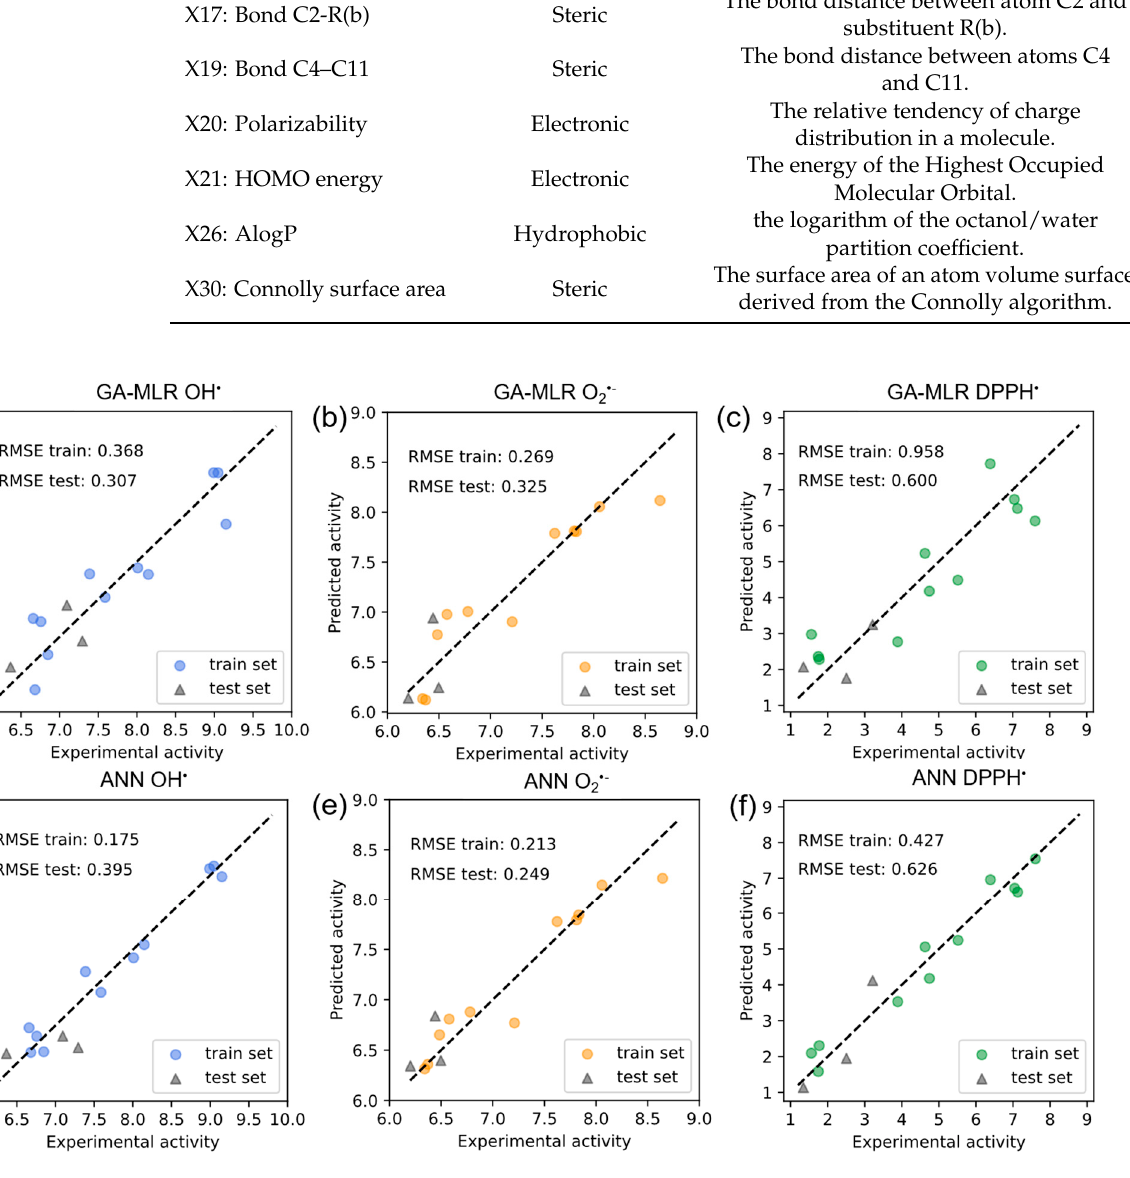
Figure 3. Experimental vs. predicted • OH, O 2• − , and DPPH • scavenging activities (percent scaveng- ing activity/10) for training and test sets. The predicted data were obtained from QSAR GA-MLR ( a – c ) and QSAR-ANN ( d – f )